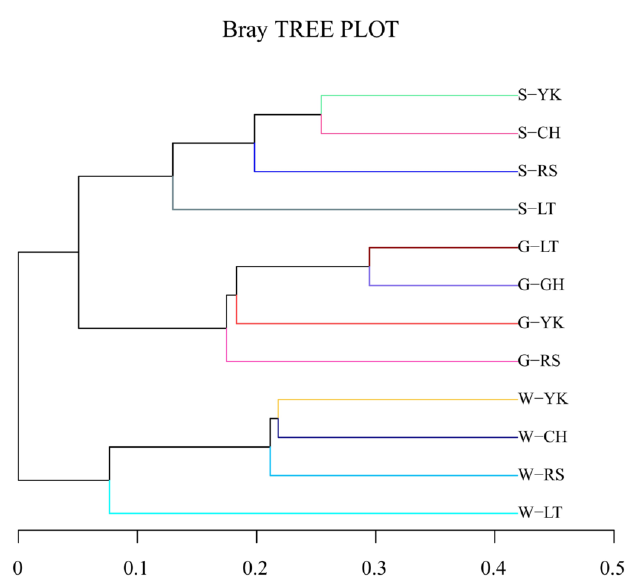
Figure 4. Cluster dendrogram. The length of the branches represents the distance between the samples; the more similar the samples are, the closer they will be. The branches of the same color in the figure represent the same group.